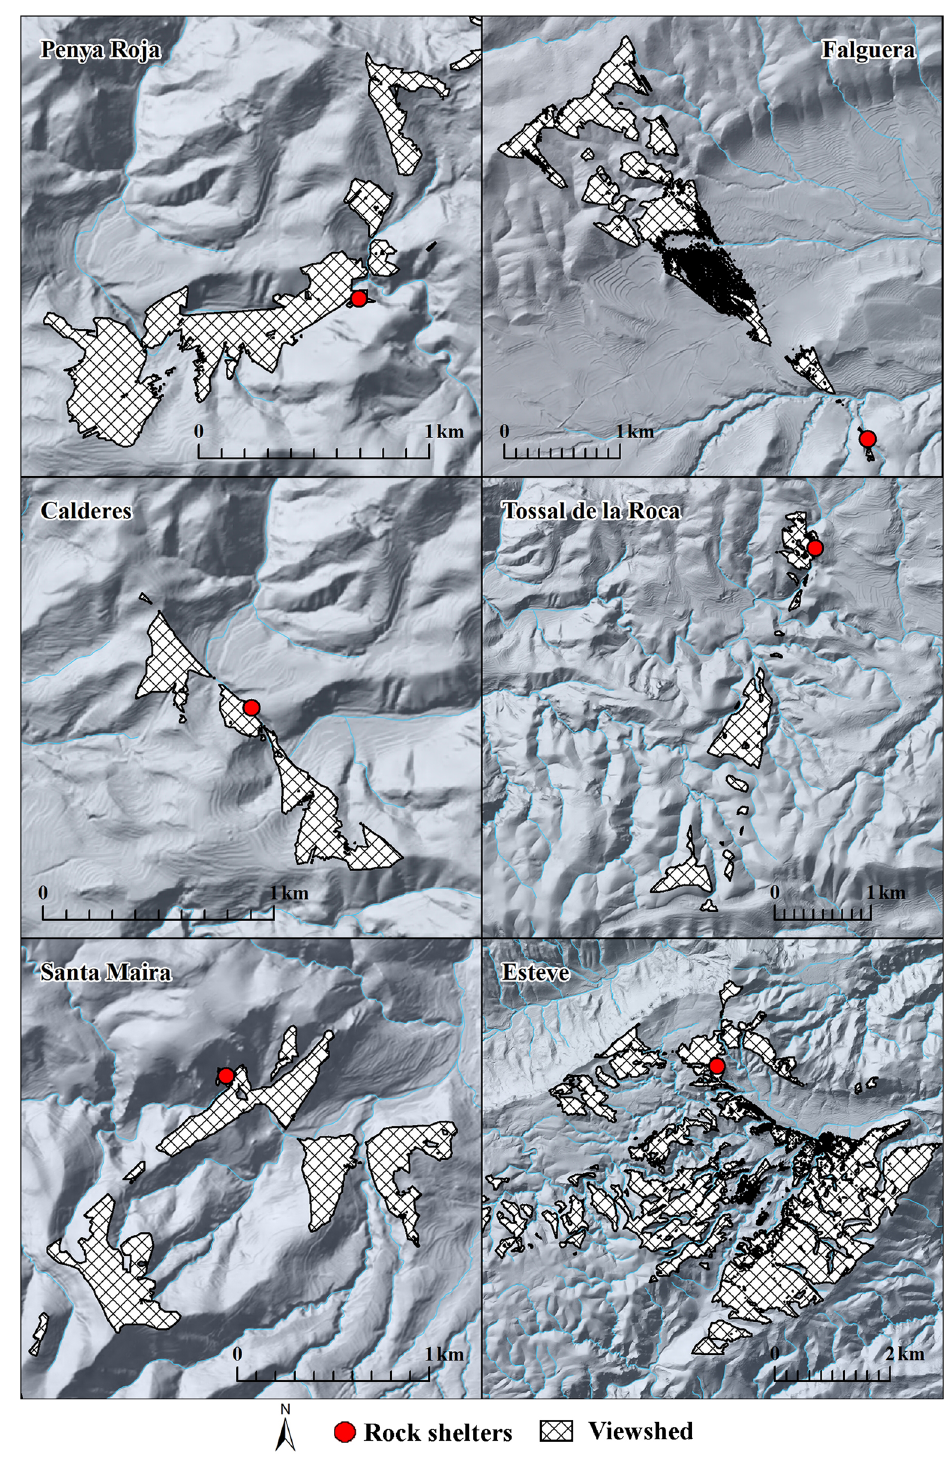
Figure 6: Viewshed